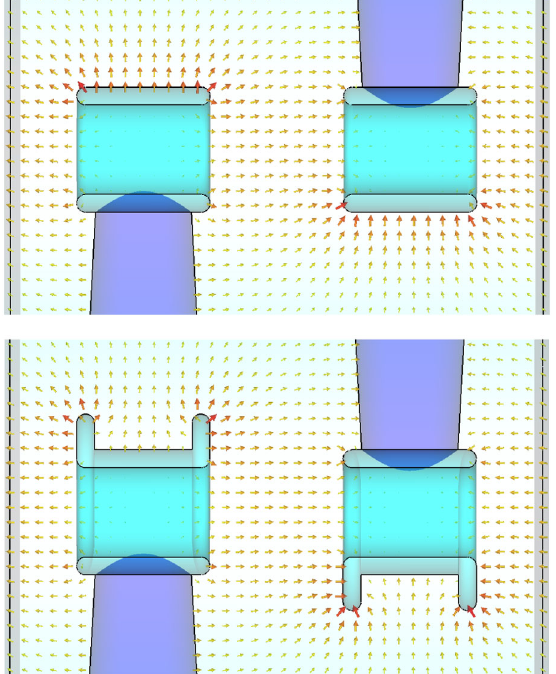
FIG. 8. Electric-field arrows in the axial vertical plane for one ¼ 0 : 04 ) with wide gaps, g=L IH period ( (cid:1) g slim DTs (top) and same DTs with bulges (bottom).